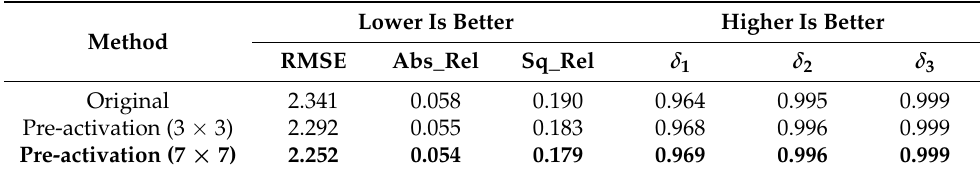
Table 10. KITTI Eigen split Evaluation Result, With Different upconvolution blocks (Except upconvo- lution block, other environments are